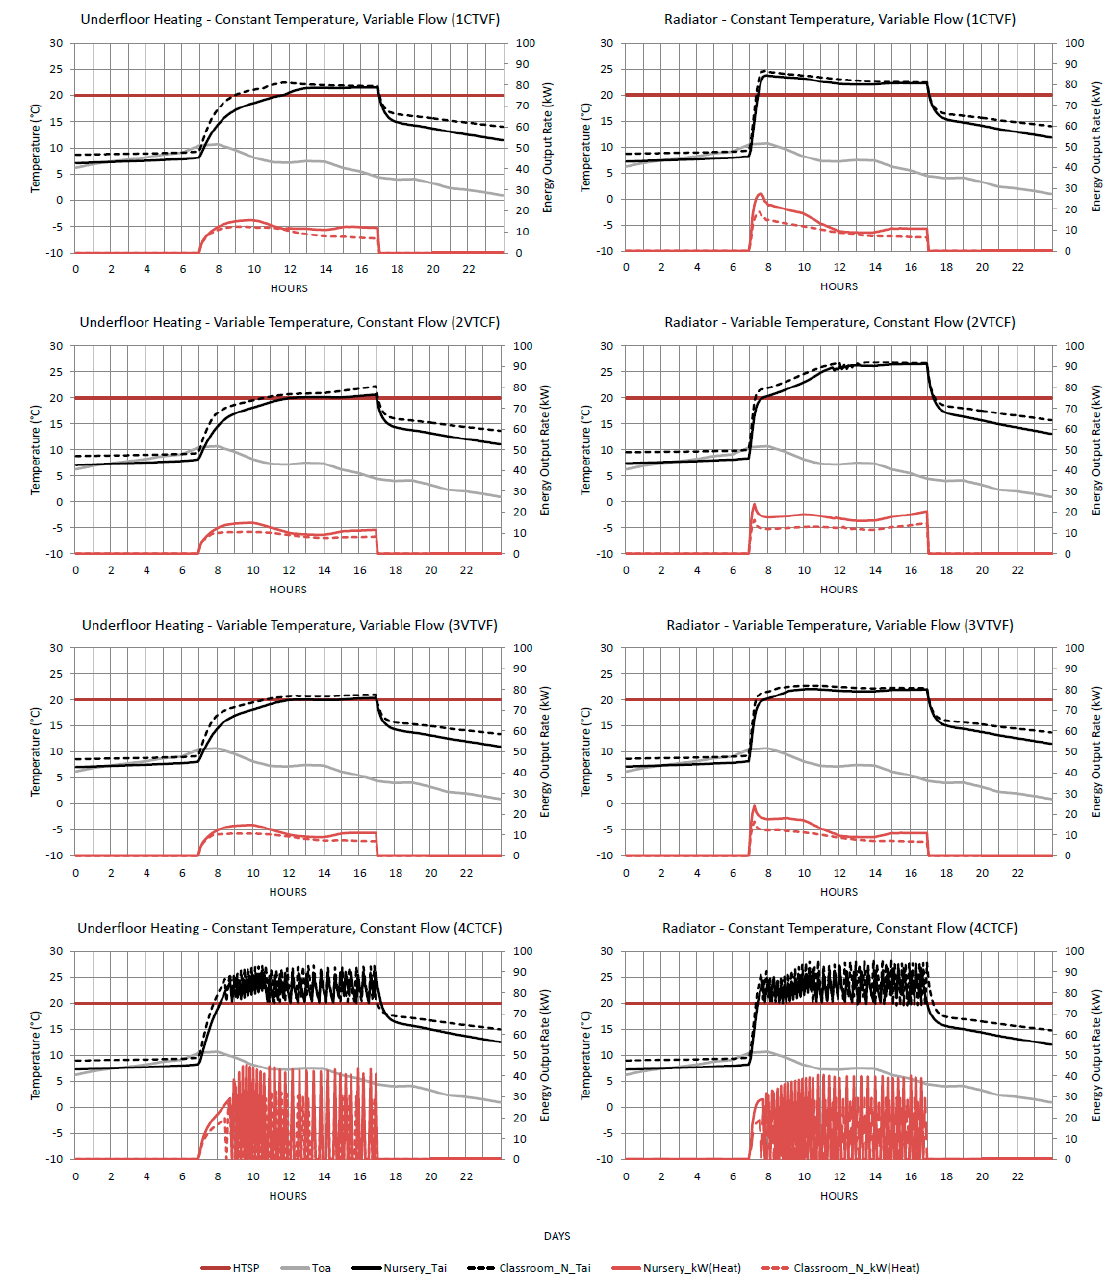
Figure 5. Temperature and energy profiles for a typical winter day.